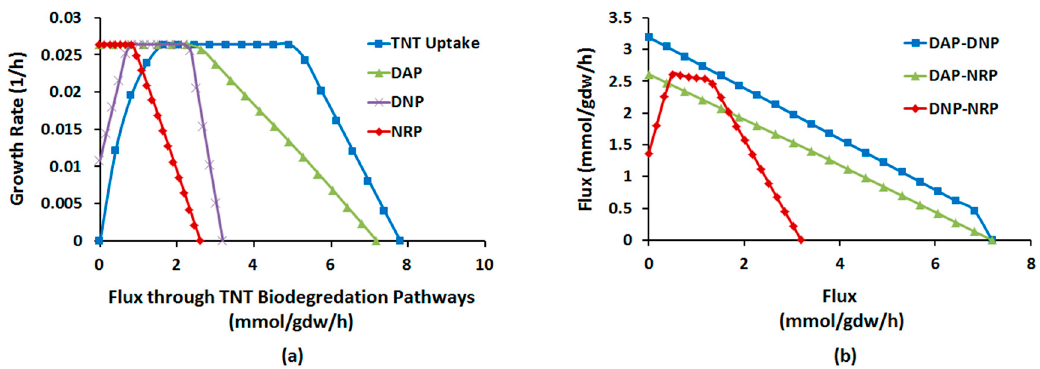
Figure 5. Robustness diagram: ( a ) anaerobic growth rate (GR) as a function of fluxes through TNT biotransformation pathways; ( b ) pair-wise sensitivity of flux through each TNT degradation pathway to another under anaerobic